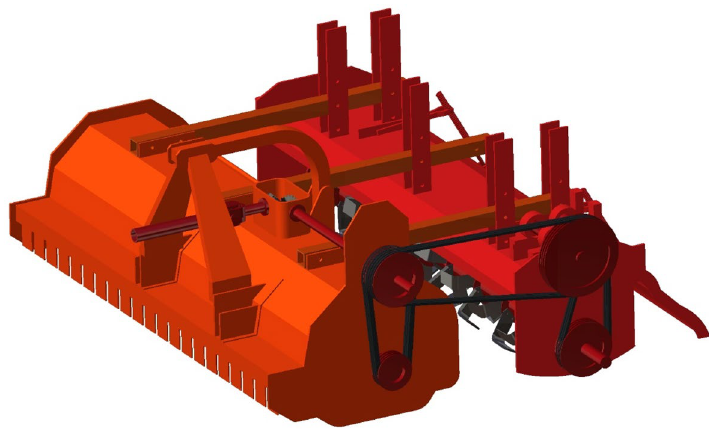
Figure 4. Isometric view of the developed residue management